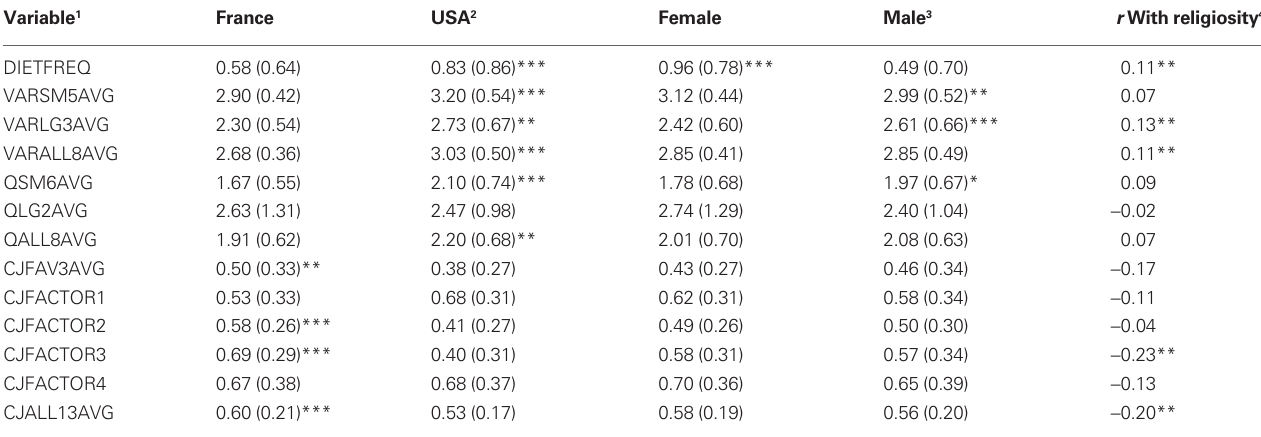
Table 2 | Means (SD) on combined variables and DIETFREQ by groups.